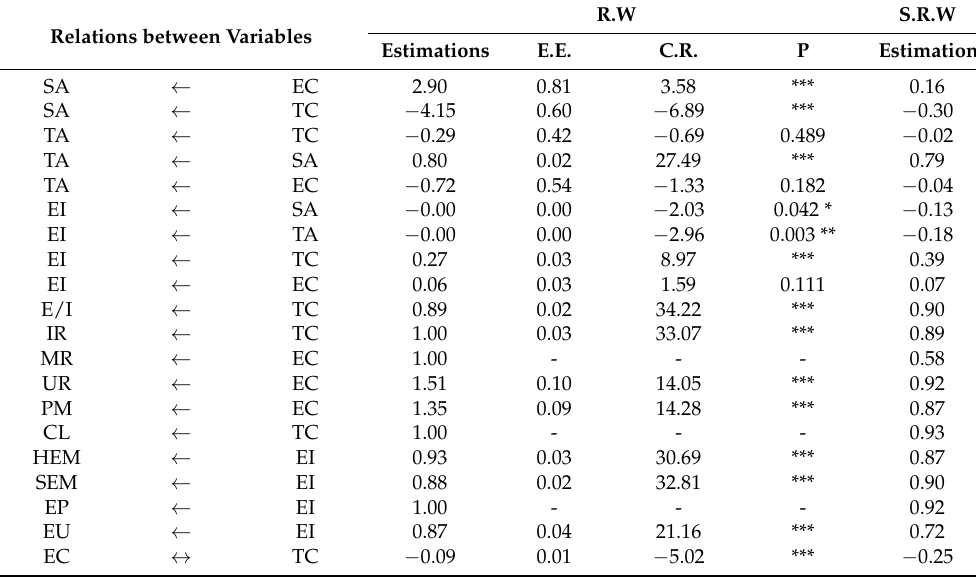
Table 2. Structural model in team